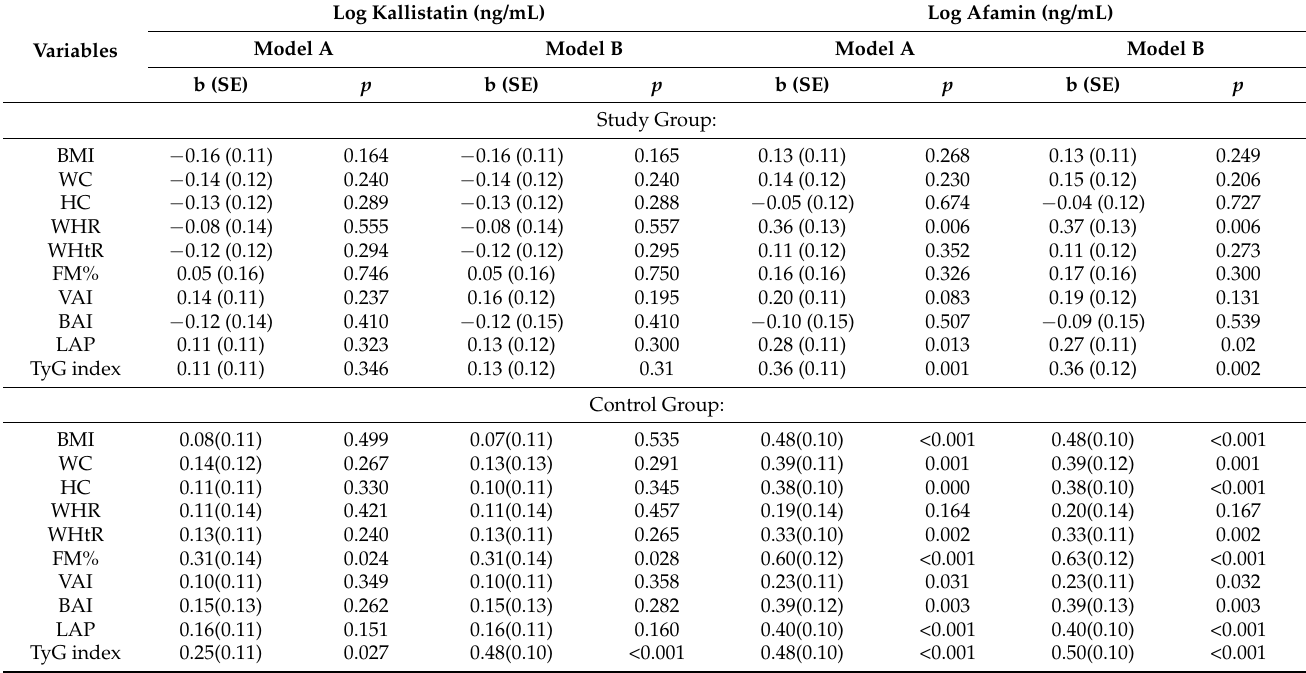
Table 3. Relationship between the concentration of kallistatin and afamin and anthropometric parameters describing overweight and obesity in multivariate